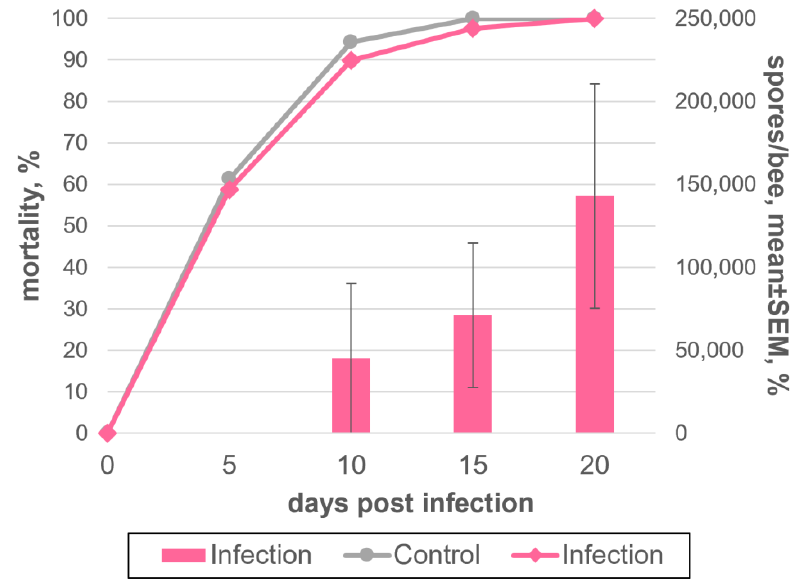
Figure 3. Dynamics of Vairimorpha ceranae development in newly emerged honey bee adults, main- tained at 25 °C and experimentally infected with 1 million spores/bee; the spores were isolated from dried honey bee cadavers stored at room temperature. The indications are as in Figure 2. The data which this scheme was created from are found in Table S2.